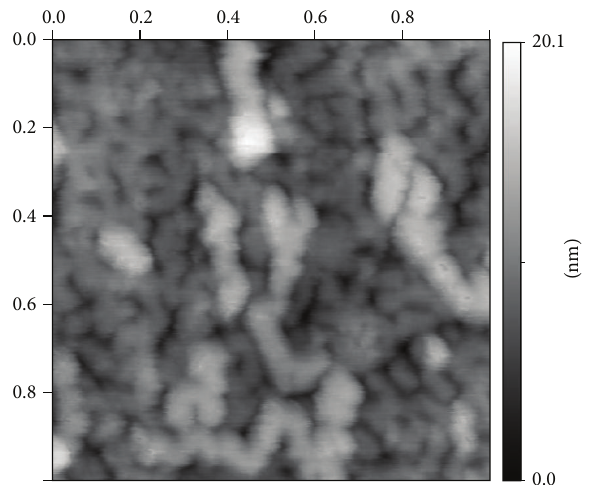
Figure 2: Surface of two-phase ferriferous alkali borosilicate glass Fe25 in a part free from agglomerates. The snapshot size - 1 × 1 𝜇 m 2 . The scale on the right-relief height over average background.